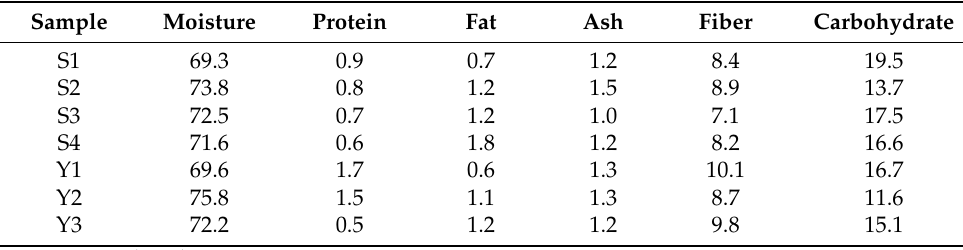
Table 2. Proximate composition of the studied BP (g/100 g